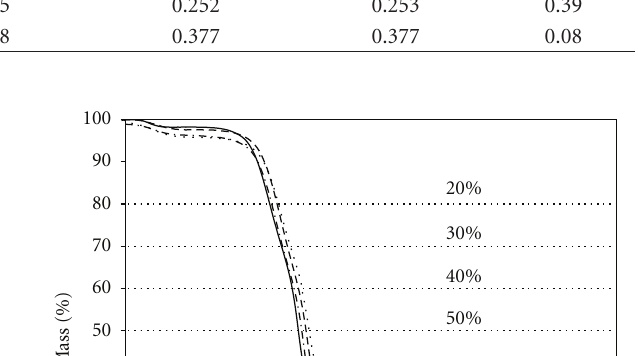
Table 7: Energy conversion e ffi ciency (ECE) estimated with equi- librium model.